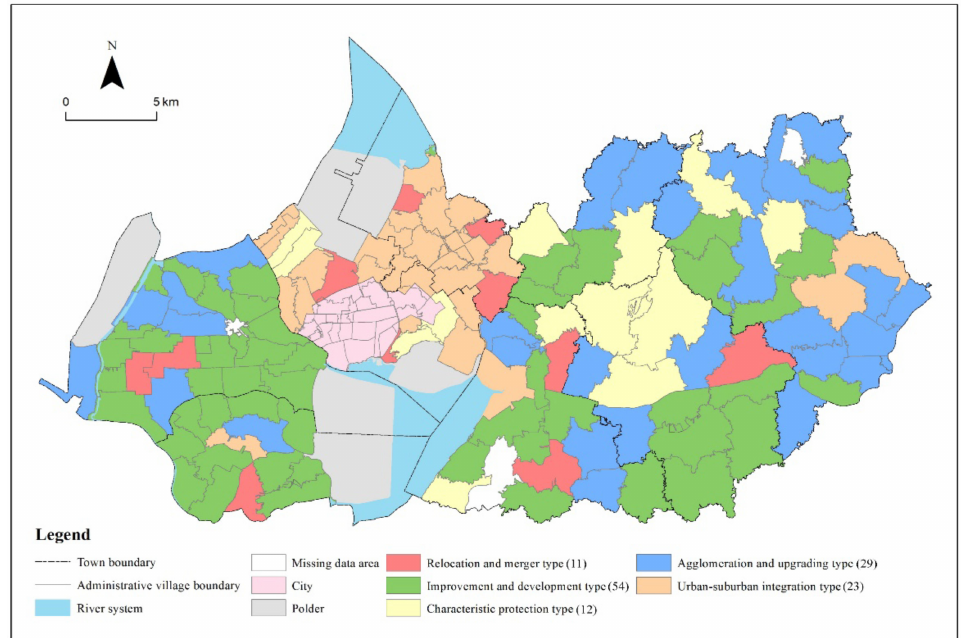
Figure 7. Results of village type identification in Gaochun